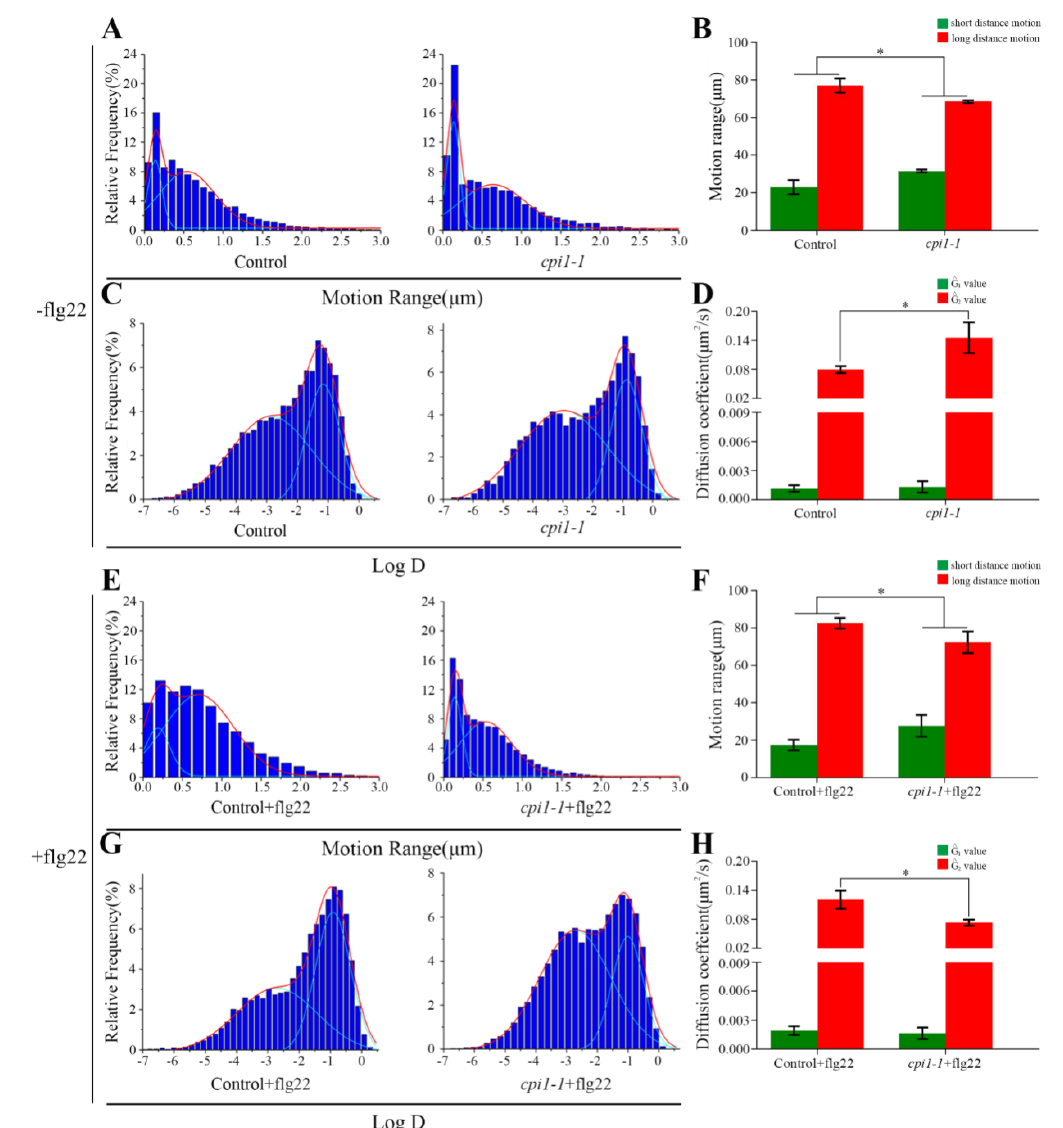
Figure 4. E ff ects of sterols on the dynamics of Flot1-GFP spots at the plasma membrane. ( A ) Distribution of Flot1-GFP motion range in control ( n = 9987 spots) and in cpi1-1 mutant ( n = 5316 spots) seedlings. ( B ) Frequency of long-distance and short-distance motions for Flot1-GFP without flg22 treatment. Error bars represent the SD ( n = 15–20). * p < 0.05, Student’s t -test. ( C ) Distribution of Flot1-GFP di ff usion coe ffi cients in control ( n = 10389 spots) and in cpi1-1 mutant ( n = 5316 spots) seedlings. ( D ) Di ff usion coe ffi cients of Flot1-GFP without flg22 treatment. Error bars represent the SD ( n = 15–20). * p < 0.05, Student’s t -test. ( E ) Distribution of Flot1-GFP motion range in control ( n = 8896 spots) and in cpi1-1 mutant ( n = 7737 spots) seedlings after flg22 treatment (15 min). ( F ) Frequency of long-distance and short-distance motions of Flot1-GFP after flg22 treatment. Error bars represent the SD ( n = 15–20). * p < 0.05, Student’s t -test. ( G ) Distribution of Flot1-GFP di ff usion coe ffi cients in control ( n = 8896 spots) and in cpi1-1 mutant ( n = 7737 spots) seedlings after flg22 treatment (15 min). ( H ) Di ff usion coe ffi cients of Flot1-GFP after flg22 treatment. Error bars represent the SD ( n = 15–20). * p < 0.05, Student’s t -test.